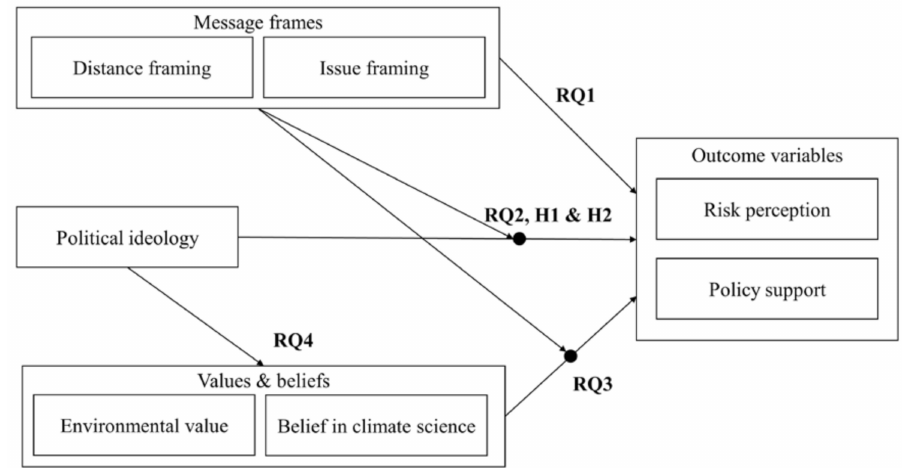
Figure 1. Theoretical framework of the current study with hypotheses and research